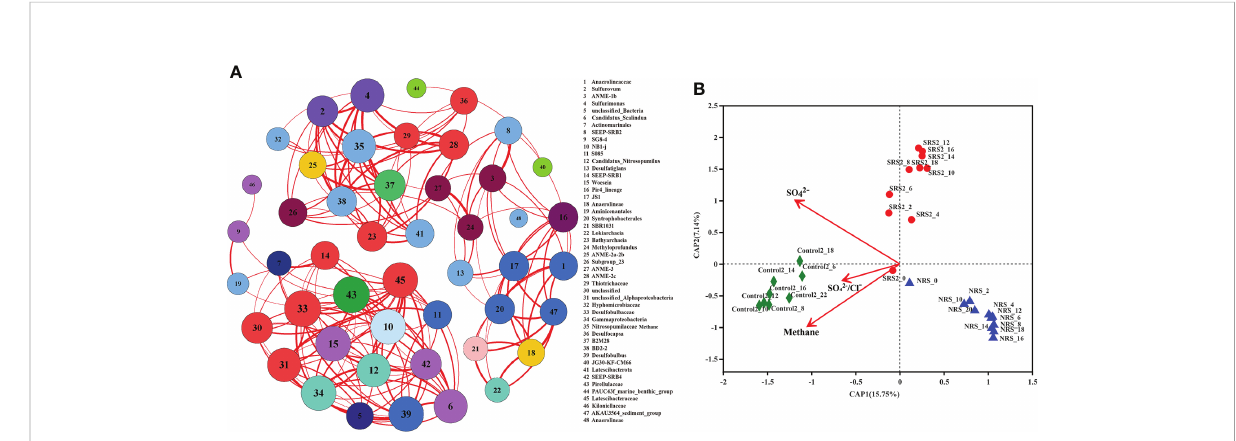
FIGURE 6 The relationship and environmental variables of microbial groups between sampling sites. (A) Co-occurrence networks of the top 50 genera in all samples with a Spearman ’ s correlation coef fi cient >0.7 or< − 0.7 and a P-value<0.01. The size of each node indicates degree of connectivity and the color indicates the phylum that the genus af fi liated to. The thickness of each line indicates strength of correlation. (B) Db-RDA the relationship of sulfate and methane changes and microbial community at the OTU level based on Bray – Curtis distances.